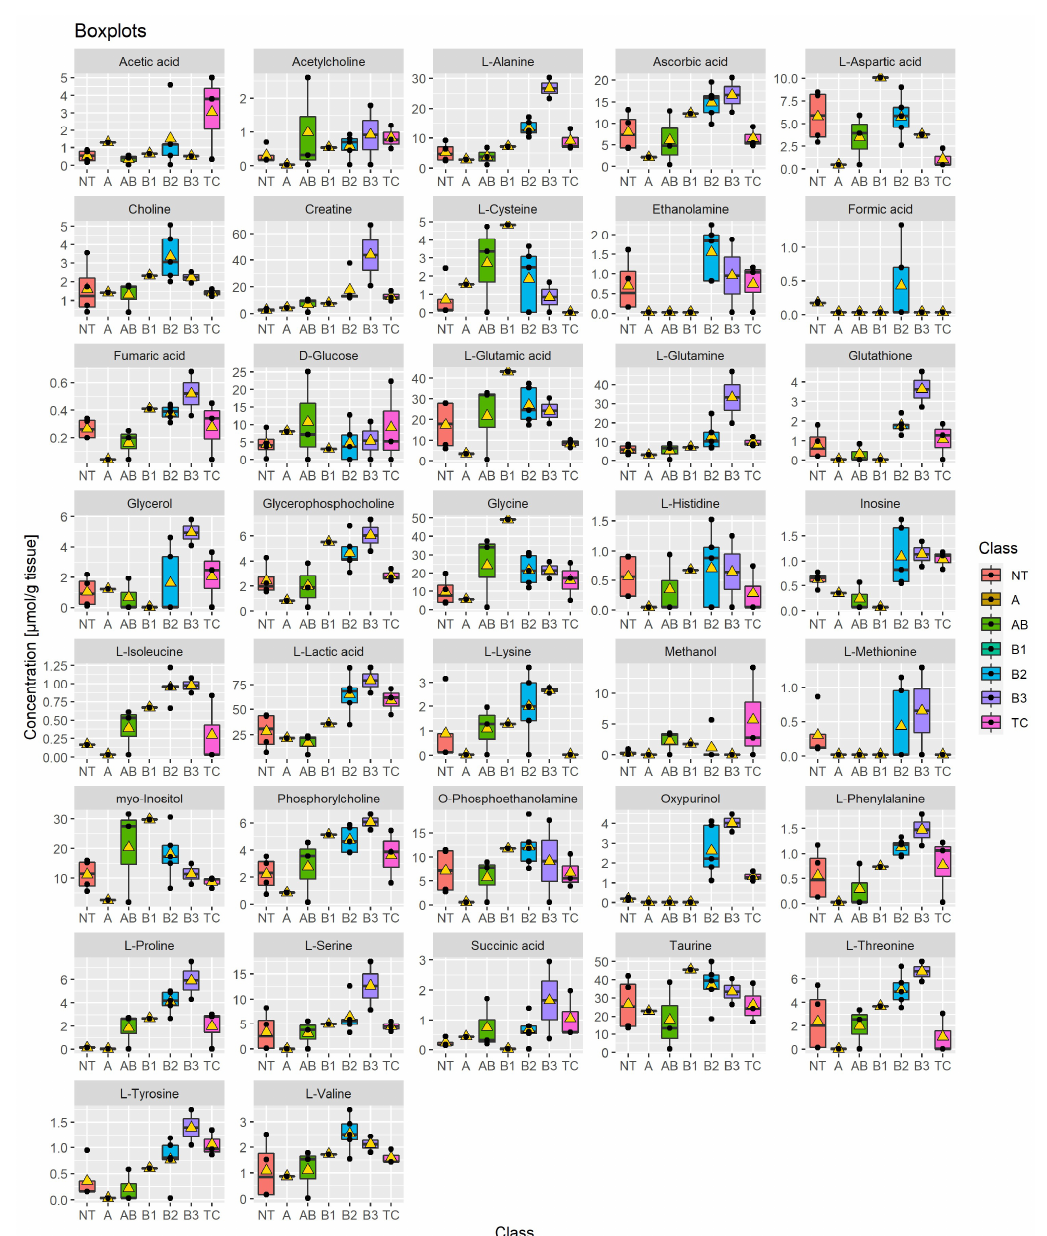
Figure 1. Boxplots showing the concentrations (y-axis) of the 37 metabolites found in normal thymi (NT, n = 4), thymomas (A, AB, B1, B2, B3, n = 12) and thymic carcinomas (TC, n = 3). The black bars show the respective median of a distribution, while the yellow triangles show the respective average. Each box is drawn from the 25th to the 75th percentile. Please note that the scale of the y-axis was adapted to the concentration range and is therefore different among the different metabolites.